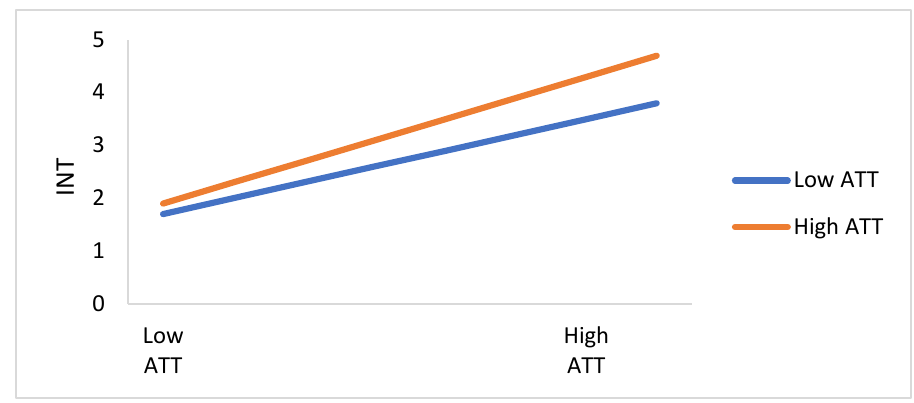
Figure 7. The plot of the moderating effect of health infodemics on the relationship between TRSM and INT.